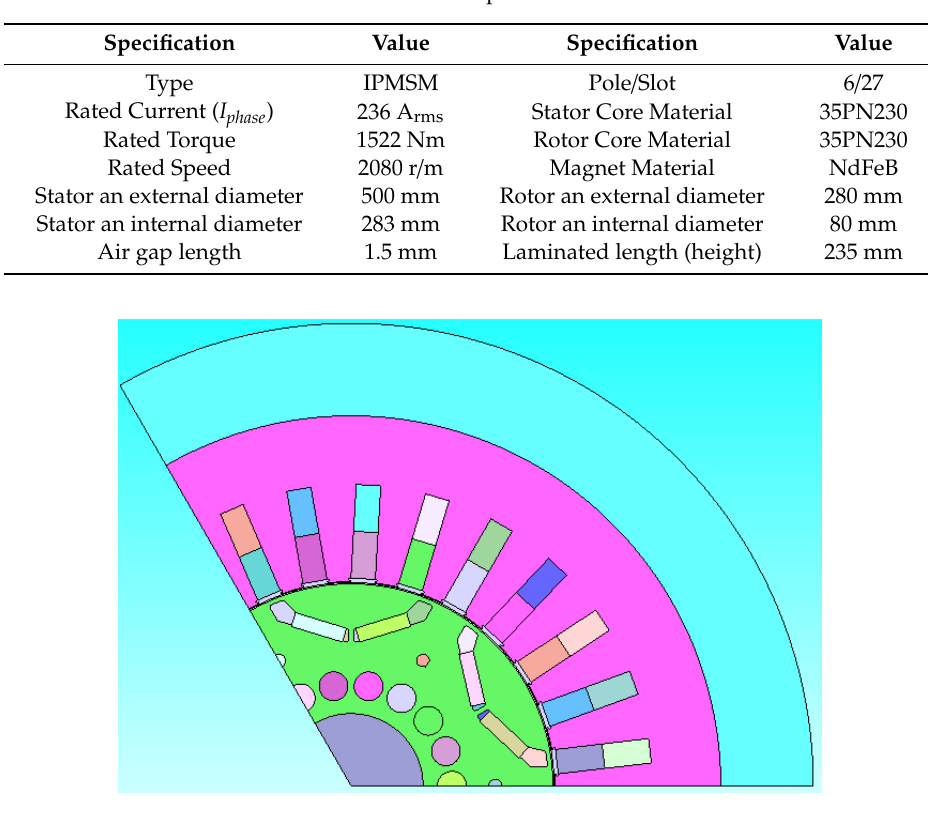
Table 1. PMSM specifications.